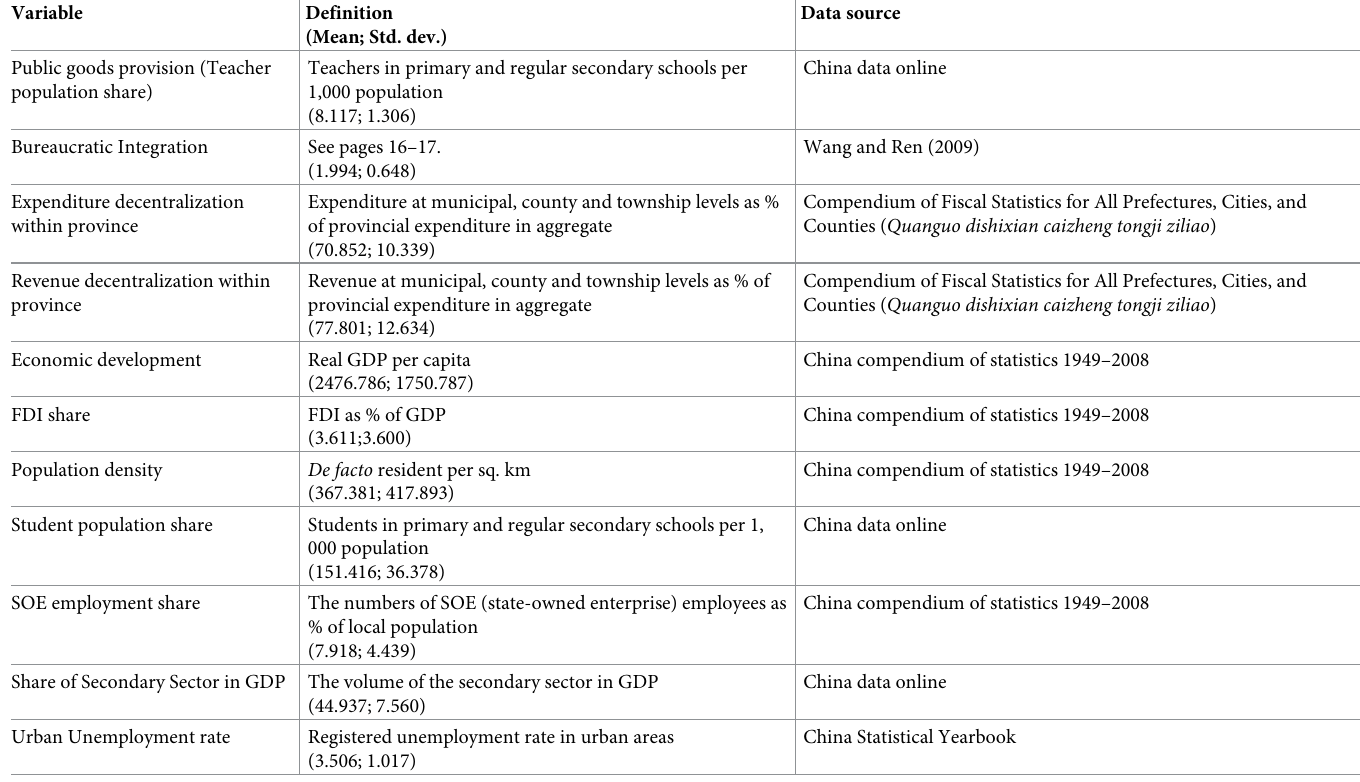
Table 1. Variable definition, descriptive statistics and data source, 1995–2007.